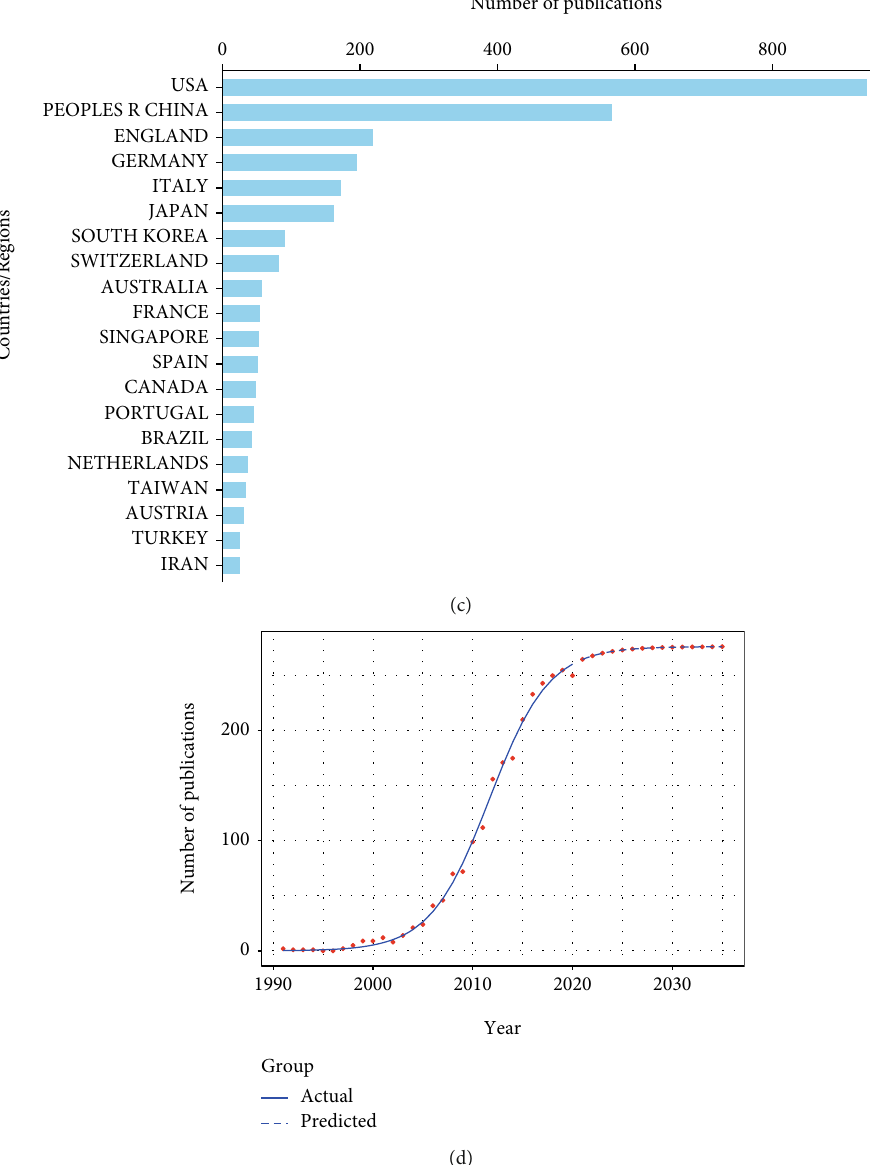
Figure 1: (a) The total number of publications related to the publications of tendon stem cells. The blue bars indicate the number of publications each year. (b) Distribution of the publications of tendon stem cells in a world map. (c) The top 20 countries of total number of publications. (d) Model fi tting curves of trends in global